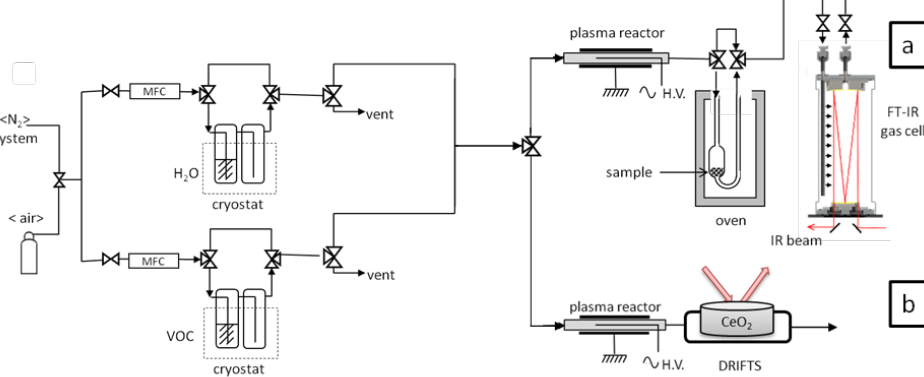
Figure 1. Schematic representation of experimental setups equipped with ( a ) gas phase FTIR monitoring device and ( b ) surface analysis by diffuse reflectance infrared Fourier transform device (DRIFT).